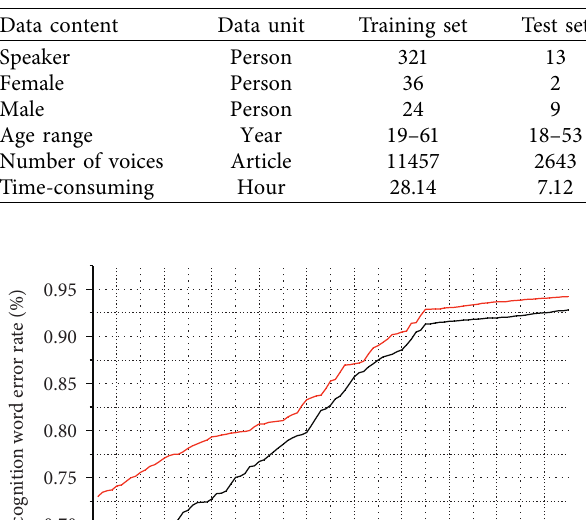
Figure 2: The framework of the speech recognition system. Table 2: Phonetic composition of the data set.